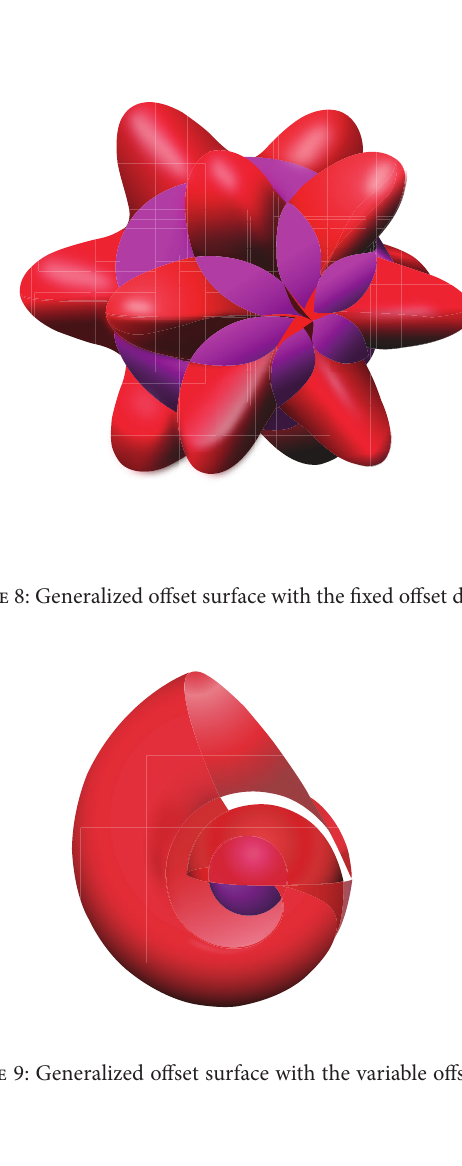
Figure 7: Flower cloth.